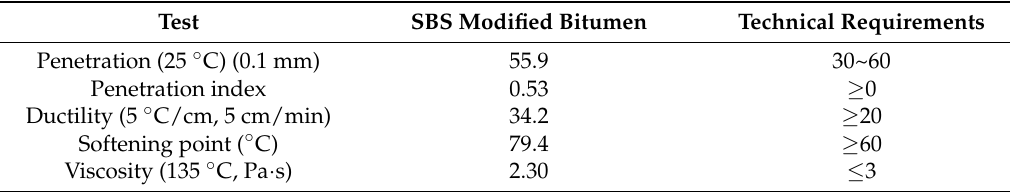
Table 2. Basic properties of the asphalt binder.